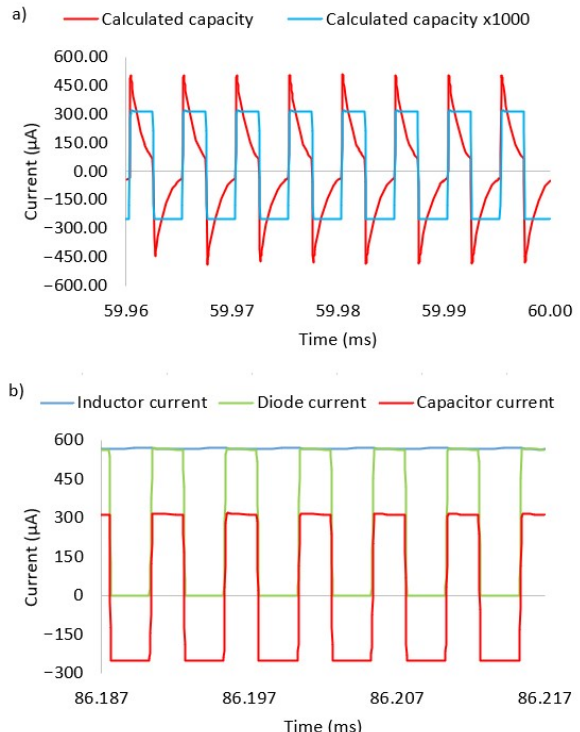
Figure 5. The boost converter simulation: ( a ) comparison of the boost converter capacity value and the capacity value increased by 1000 times, ( b ) simulation of PV-powered boost converter with resistive load.